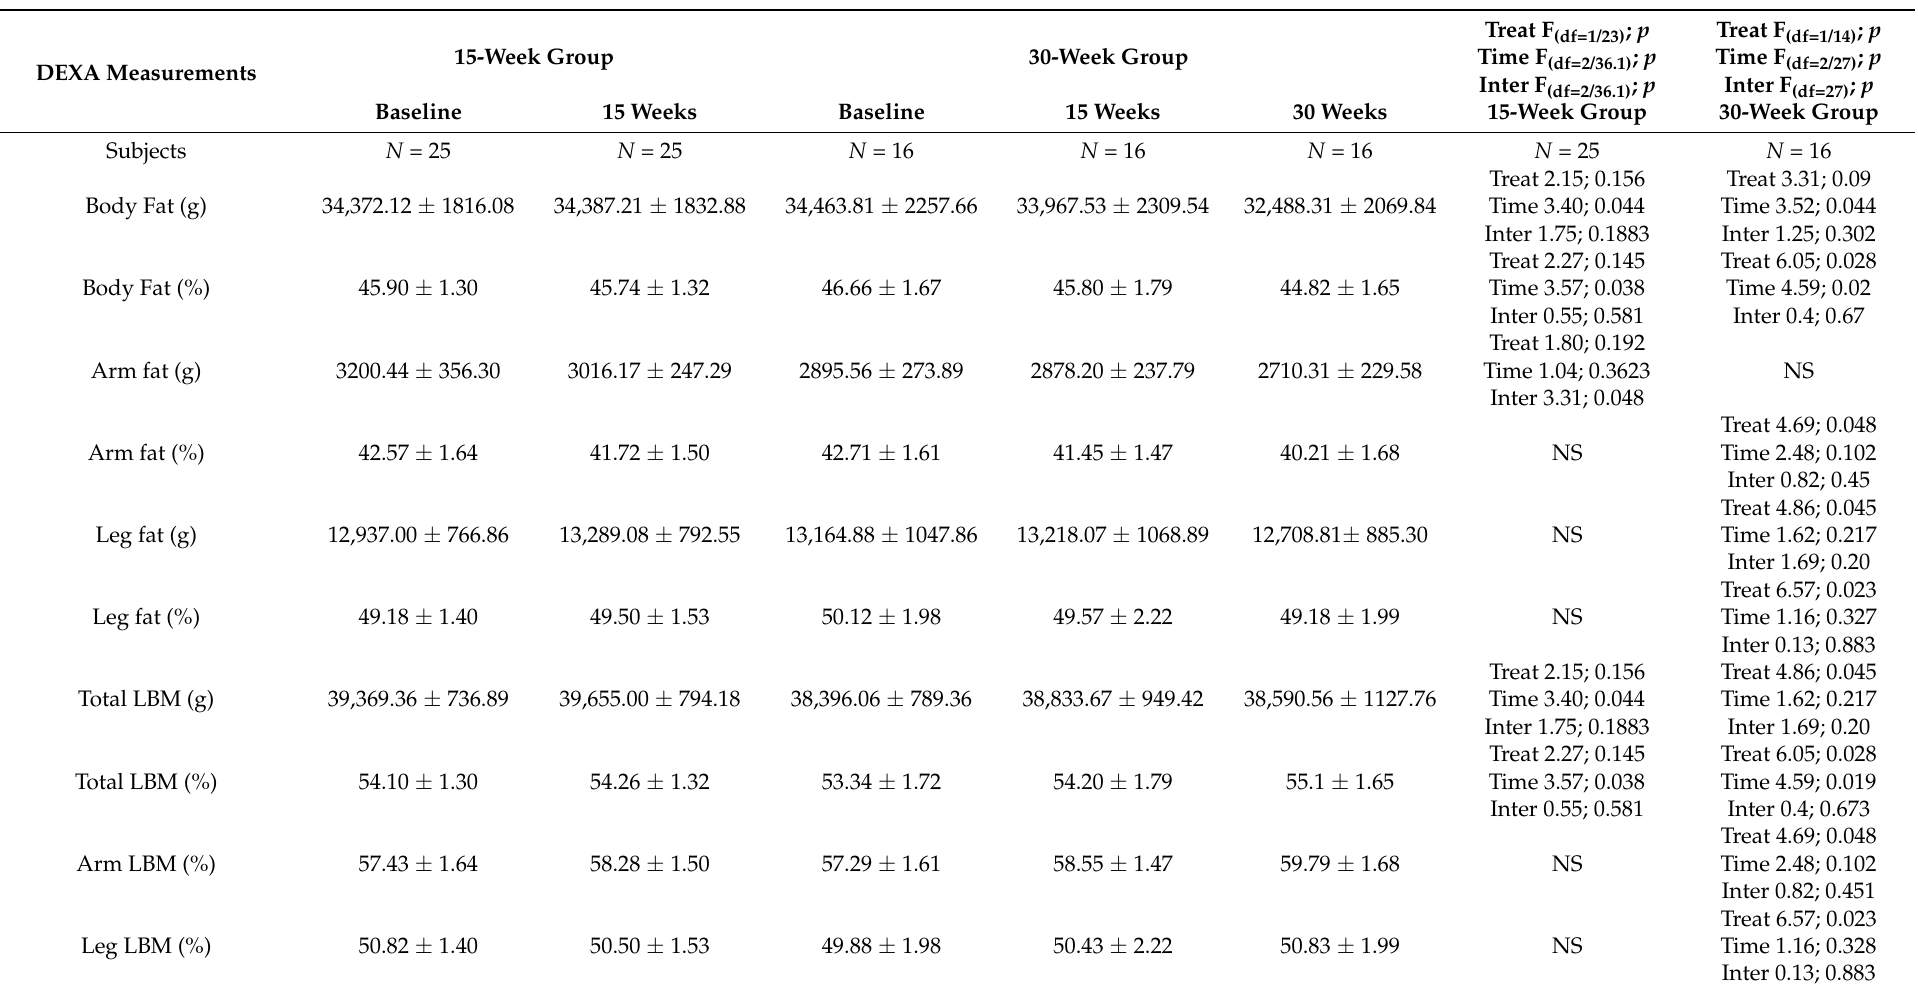
Table 4. Effects of 15 and 30 weeks of walking, independent of speed, measured by DXA and anthropometric equations, on total and regional fat and lean body